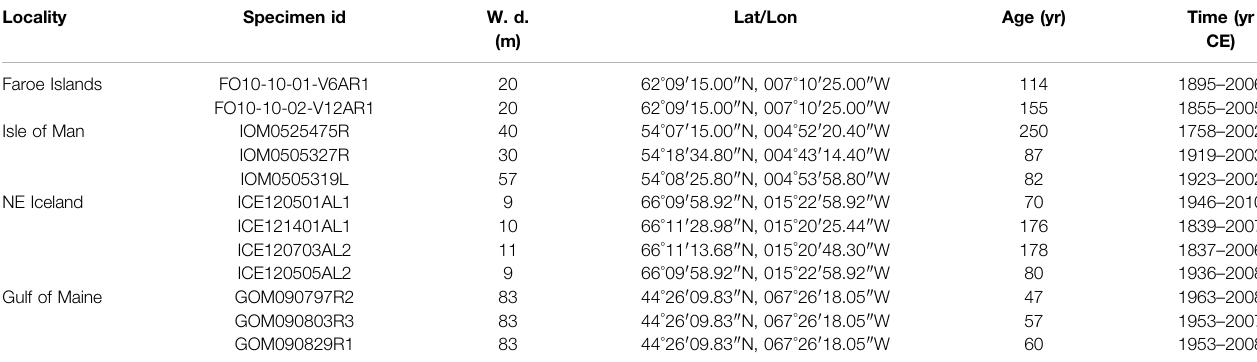
TABLE 1 | Overview of shells of Arctica islandica used in present study. Except for specimen IOM0525475R, all bivalves were collected alive. W. d. = Water depth; Age = Ontogenetic age); Time = Studied time interval. Locality Specimen